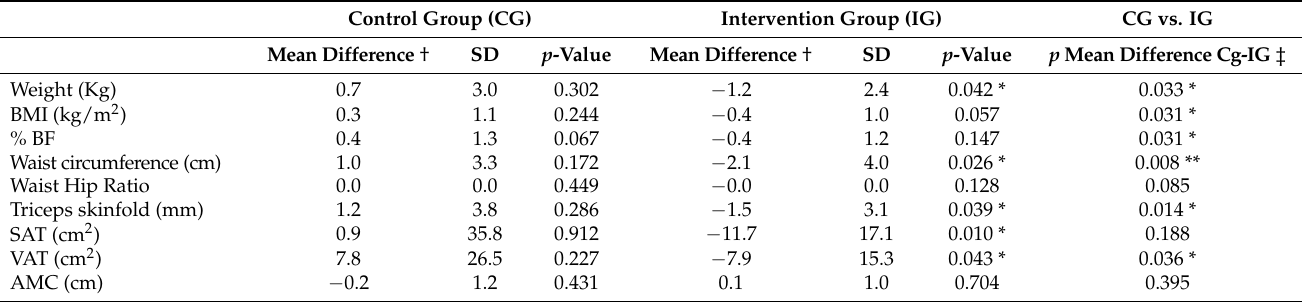
Table 2. Changes in body composition, nutritional status, and physical activity in the Control Group (CG) and Intervention Group (IG) after one year of the